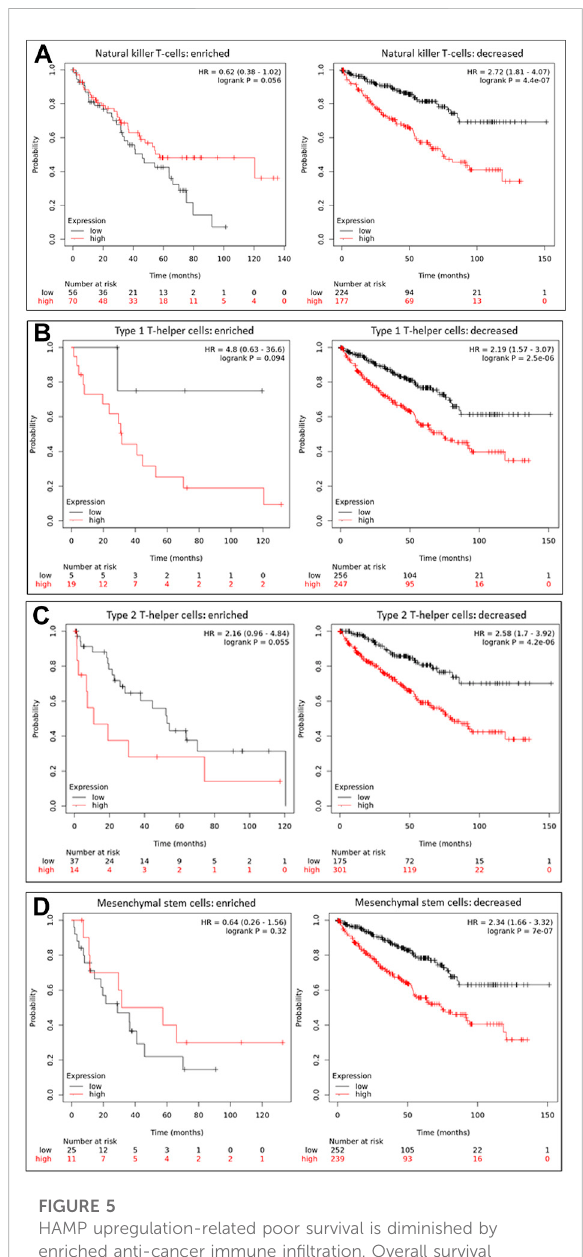
FIGURE 5 HAMP upregulation-related poor survival is diminished by enriched anti-cancer immune in fi ltration. Overall survival outcomes were analyzed based on HAMP expression levels using the minimum p-value approach on the K.M. Plotter platform, as described (Menyhart et al., 2018). Patients were strati fi ed by enriched or decreased immune in fi ltrations, including NK cells (A) , Th1 cells (B) , Th2 cells (C) , and Mesenchymal stem cells (D) . The 95% con fi dence interval of the H.R. value was listed between the